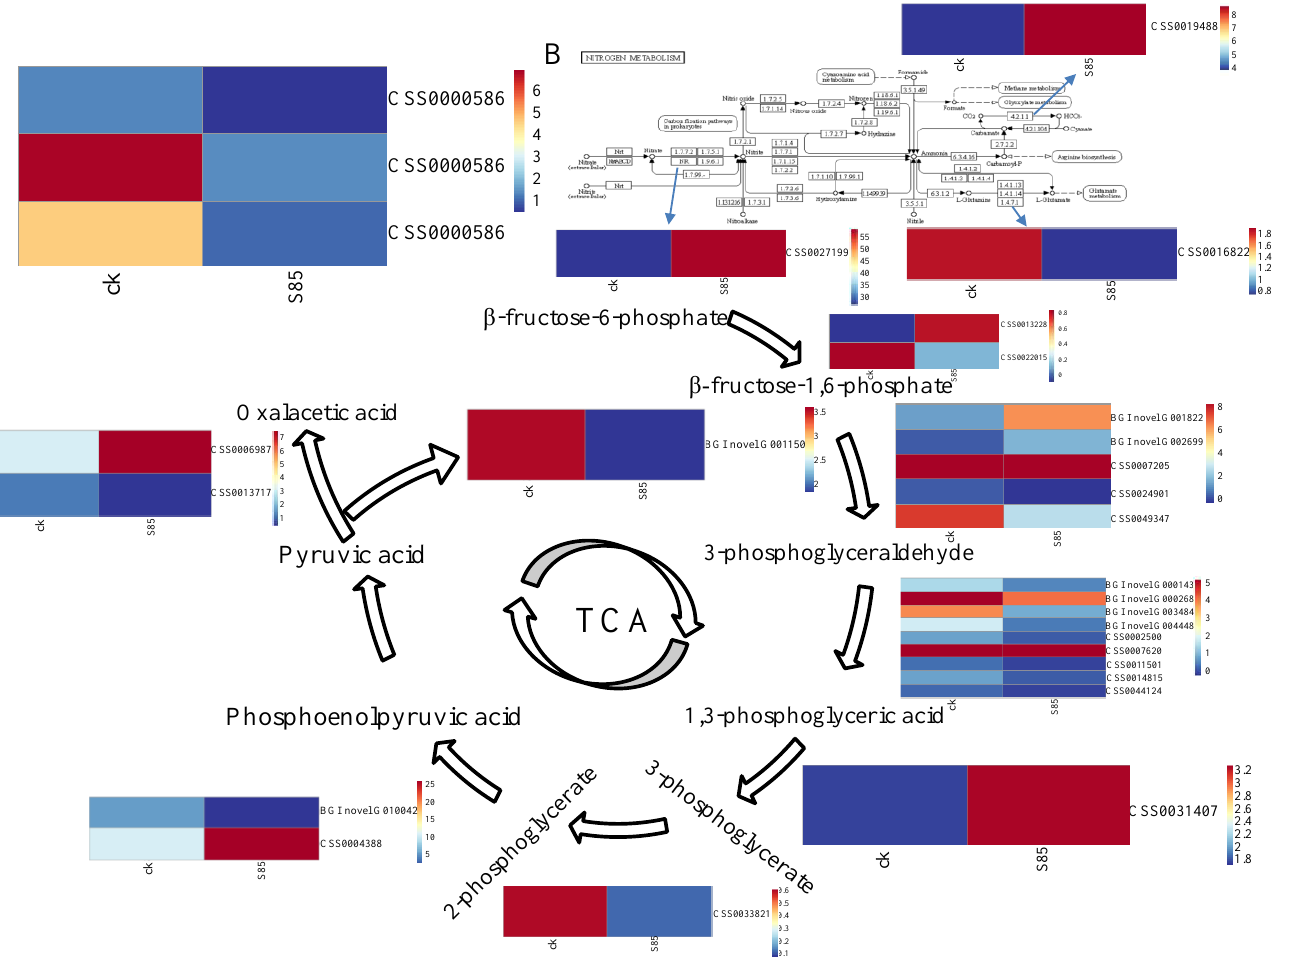
Figure 7. Differential expression profiles. ( A ) Genes related to pyruvate metabolism ( B ) Genes involved in nitrogen metabolic pathways ( C ) Amino acid permease genes.